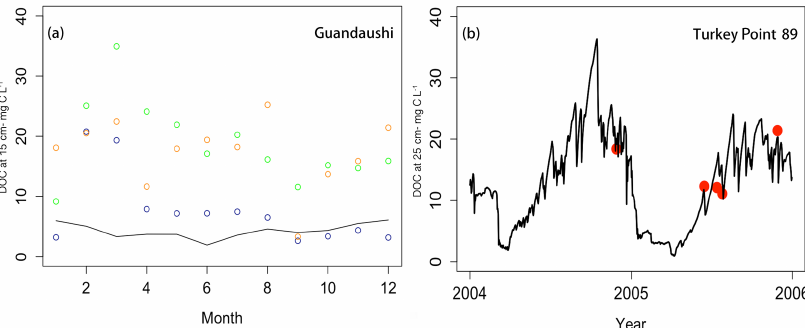
Figure 4. DOC concentration (mgCL − 1 ) for (a) Guandaushi at 15cm measured (black circle: Chinese fir, green circle: natural hardwood, orange circle: secondary wood) and simulated (black lines) and for (b) Turkey Point 89 at 25cm measured (red dots) and simulated (black lines). Results for other depths are given in Fig.